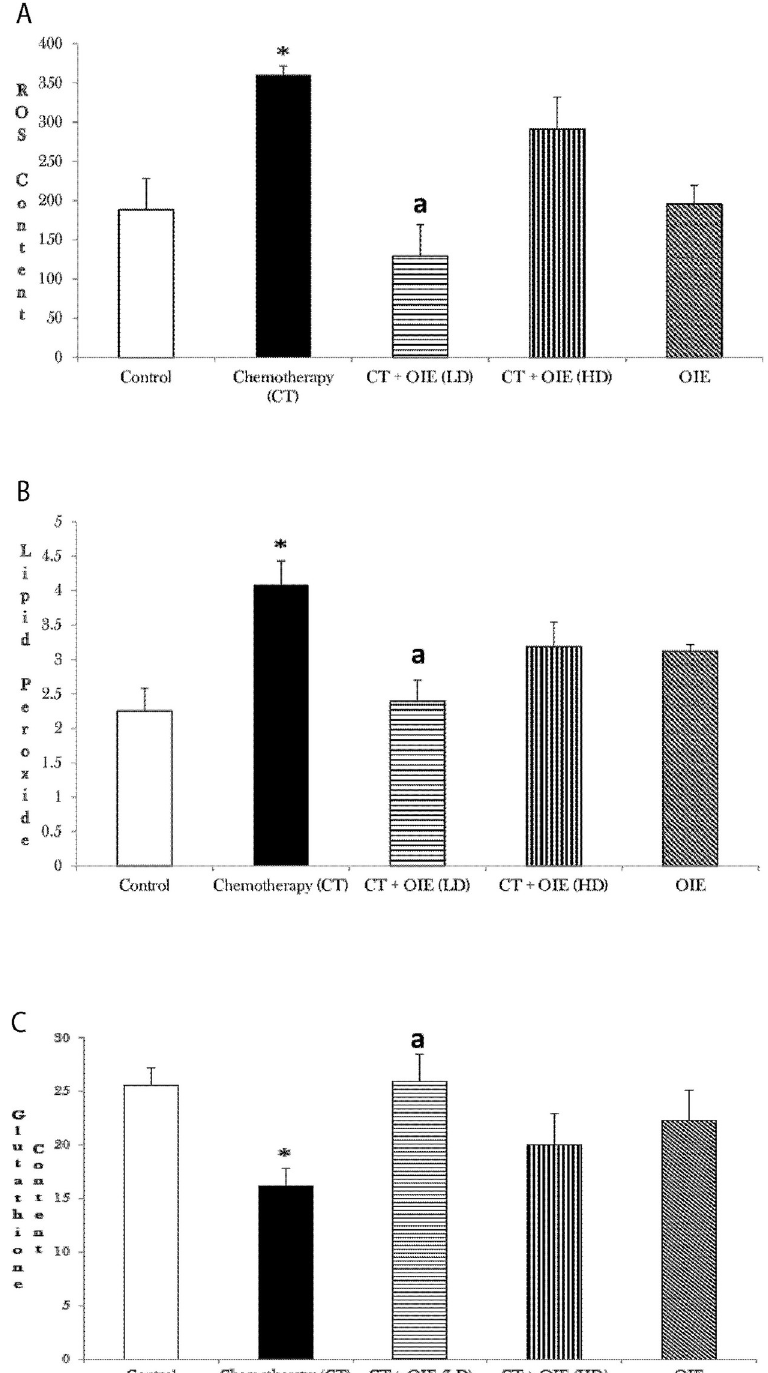
Fig 3. Effect of CT &/or OIE on the levels of ROS, lipid peroxidation and Glutathione content in the cortex. (a) The levels of oxidative stress marker-ROS in the cortex were measured spectrofluorimetrically as relative fluorescence units (492/527 nm)/mg protein. (b) Lipid peroxide formation was measured as TBARS formed (532 nm)/mg protein. (c) Glutathione content was measured spectrofluorimetrically and expressed as GSH content ( μ M)/mg protein, mean ± SEM (n = 5) � p < 0.05 vs. control mice, a p < 0.05 vs. CT mice.